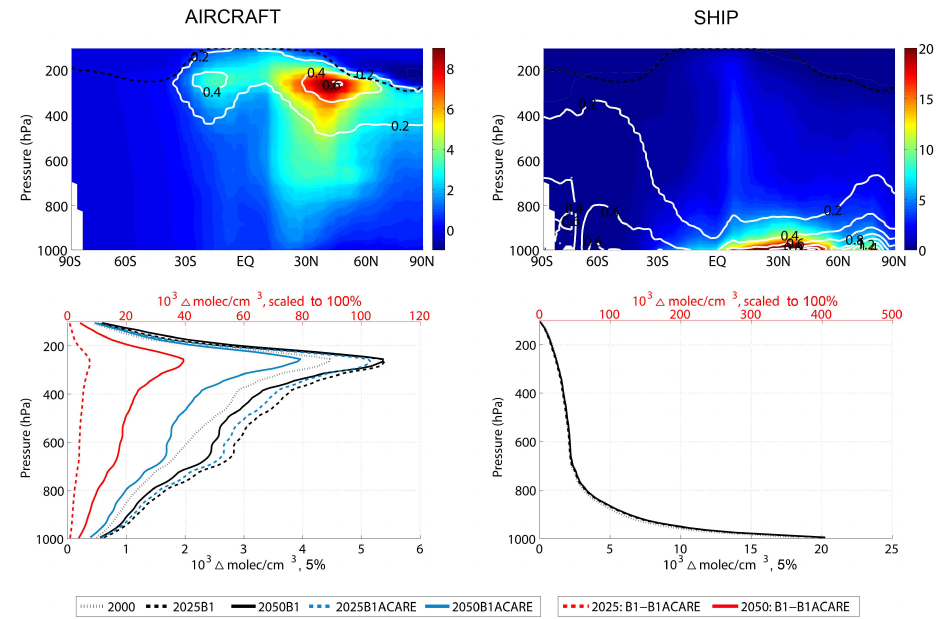
Fig. 11. Zonal mean perturbations of OH (10 3 1 molec cm − 3 ) in July due to a 5% perturbation of aircraft emissions (left) and ship emissions (right), for the 2050 B1 scenario (top) and the average Northern Hemisphere vertical profile for all years and scenarios (bottom). In the top figures, solid contour lines show the change relative to the BASE simulation while the dashed line indicates the tropopause. The colorbar and the bottom x-axis show the unscaled impact of the 5% perturbation of the emissions, while the red scales in the bottom figures are scaled up by a factor 20 from 5% to 100% and refer to all lines. The red lines show the difference between the B1 and B1ACARE scenarios and refer to the red axis only. Note that different scales are used for AIR and